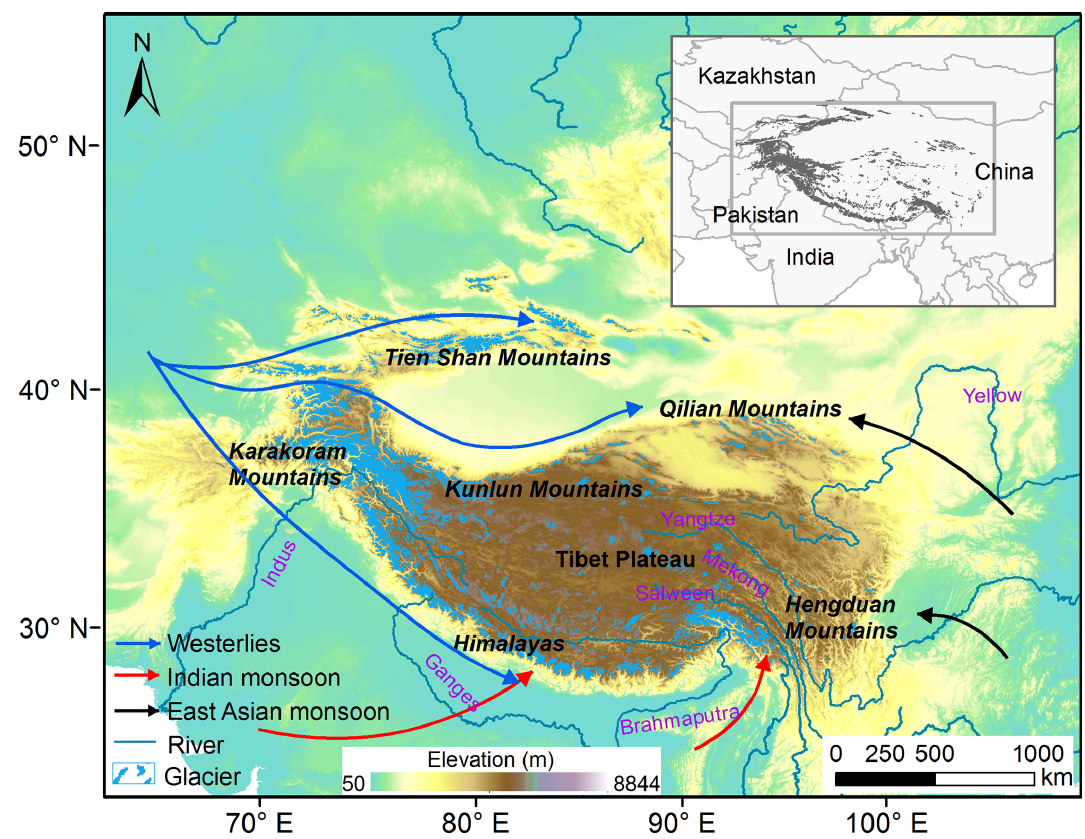
Figure 1. Location of the HMA region. Glacier outlines from the Randolph Glacier Inventory (RGI v5.0), the Second Chinese Glacier Inventory (CGI2), and the Glacier Area Mapping for Discharge from the Asian Mountains (GAMDAM) glacier inventory are drawn in blue. Publisher’s remark: Please note that the above figure contains disputed territories.